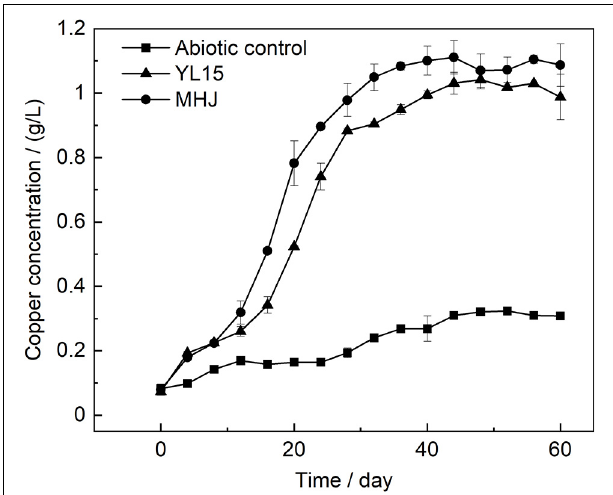
FIGURE 3 | Variation of copper concentration during chalcopyrite bioleaching.